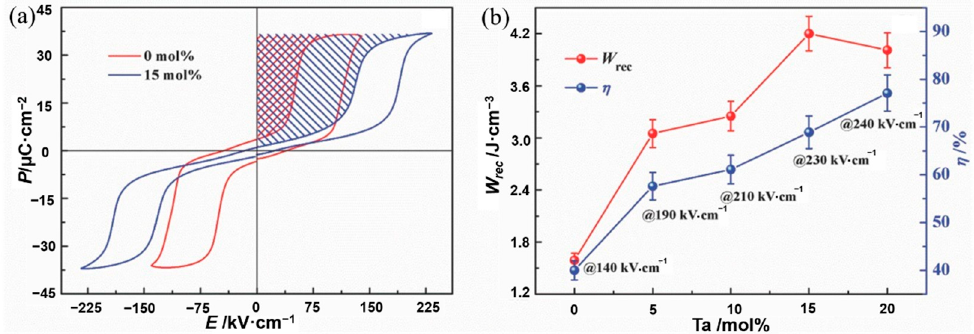
Figure 15. ( a ) Hysteresis loops of AgNbO 3 and Ag(Nb 0.85 Ta 0.15 )O 3 ceramic. ( b ) Energy storage performance of Ag(Nb 1 − x Ta x )O 3 ceramics prior to their breakdown. Reprinted with permission from [45]. Copyright 2017 WILEY-VCH Verlag GmbH & Co.